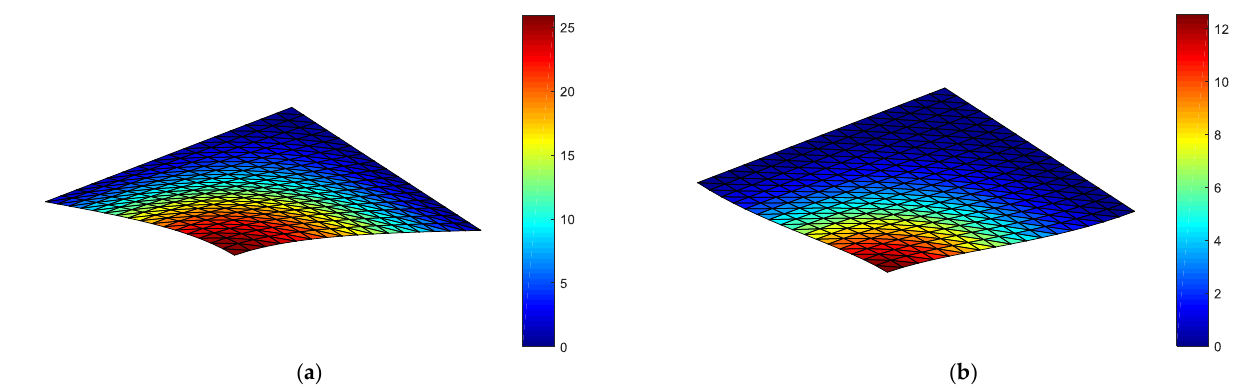
Figure 8. Central deflection for a square plate under center point load using SDKT element: ( a ) Simply supported; ( b ) clamped.